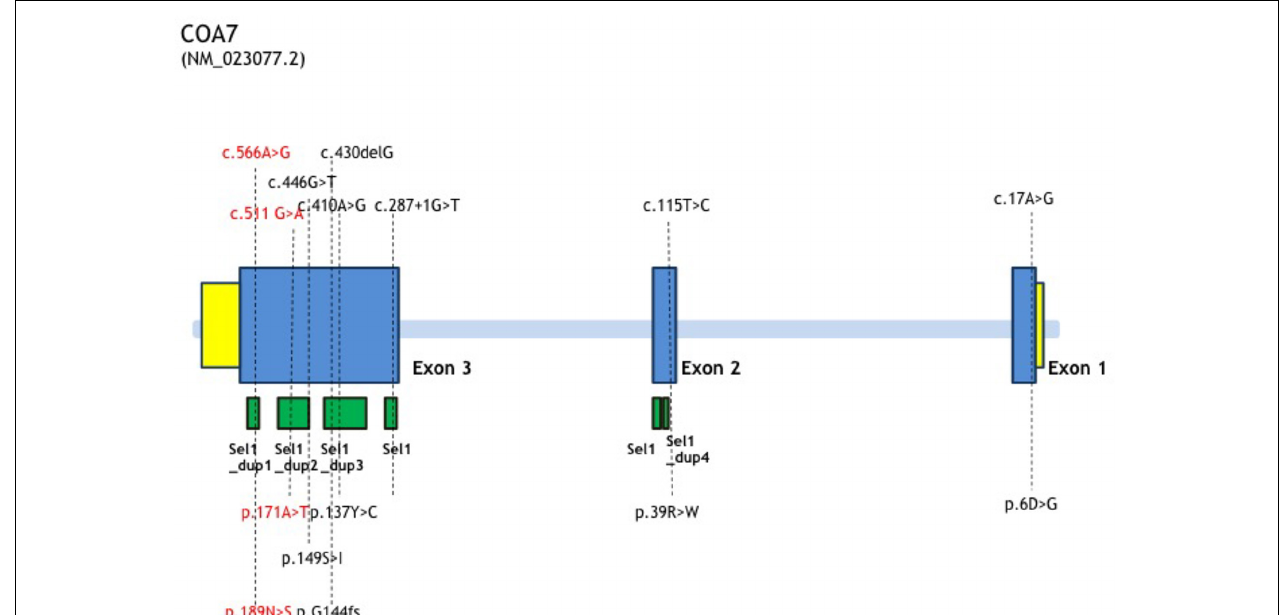
Frontiers in Genetics |